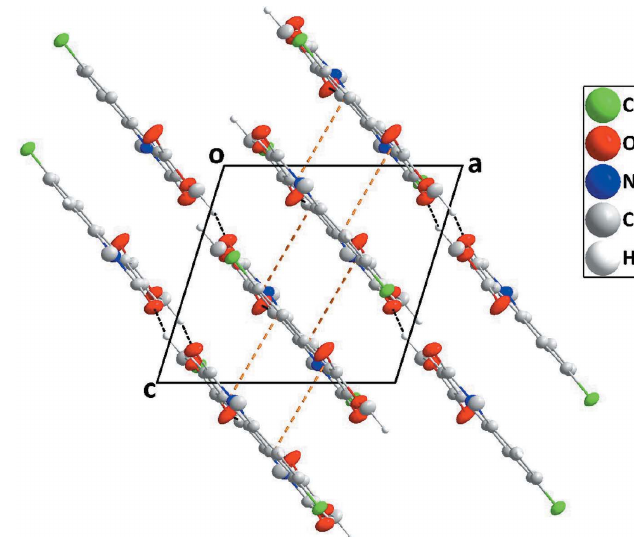
Figure 3 Packing of molecules viewed along [010] with slipped (cid:2) -stacking interactions depicted by orange dashed